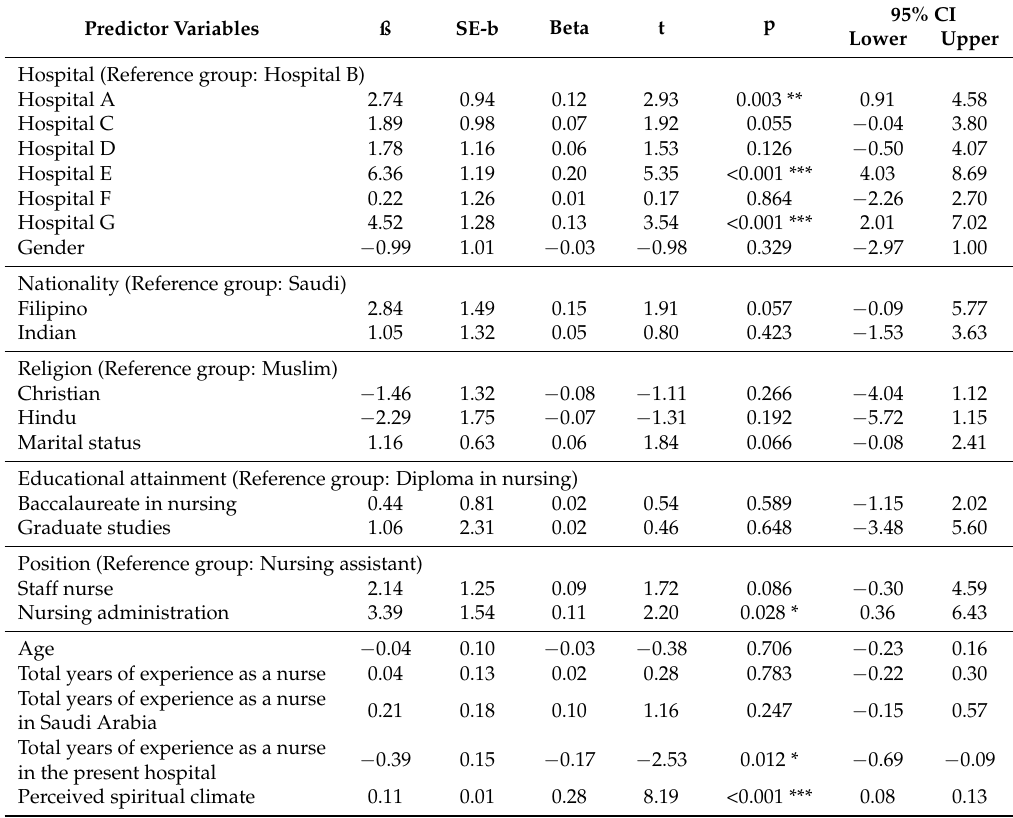
Table 5. The factors influencing the spiritual care intervention provisions among nurses (n = 918). Predictor